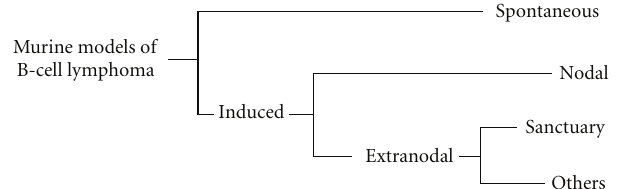
Figure 1: Schematic representation of the major subtypes of B- cell lymphoma murine models. Murine models can be either spontaneous and develop in genetically engineered mice or can be induced by implantation of a tumor cell line. In this case, it is possible to inject cells in lymph nodes (nodal location) or outside of them (extranodal location). Immune sanctuaries such as the brain or the eyes provide information about that particular situation, but many other sites can be